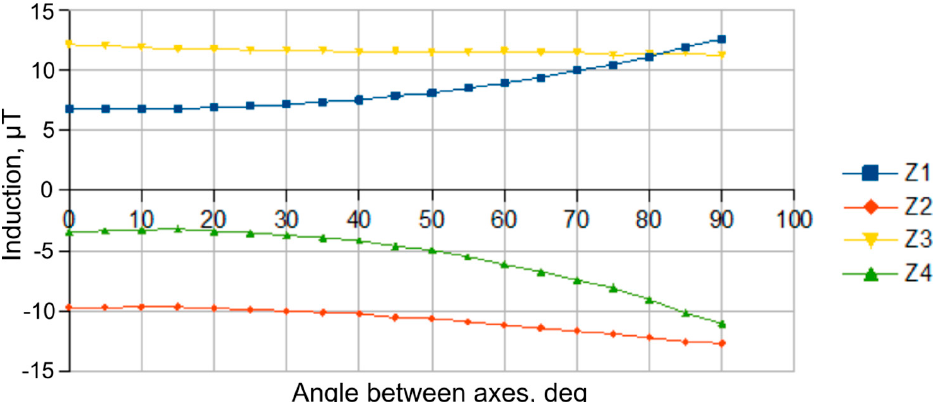
Figure 11. Dependence of the magnetic induction vector component along the Z-axis in ferroprobe cores ("Z1" − "Z4" curves correspond to "D1" − "D4" sensors) with the shield longitudinal axis and power cable axis arranged in the same plane.